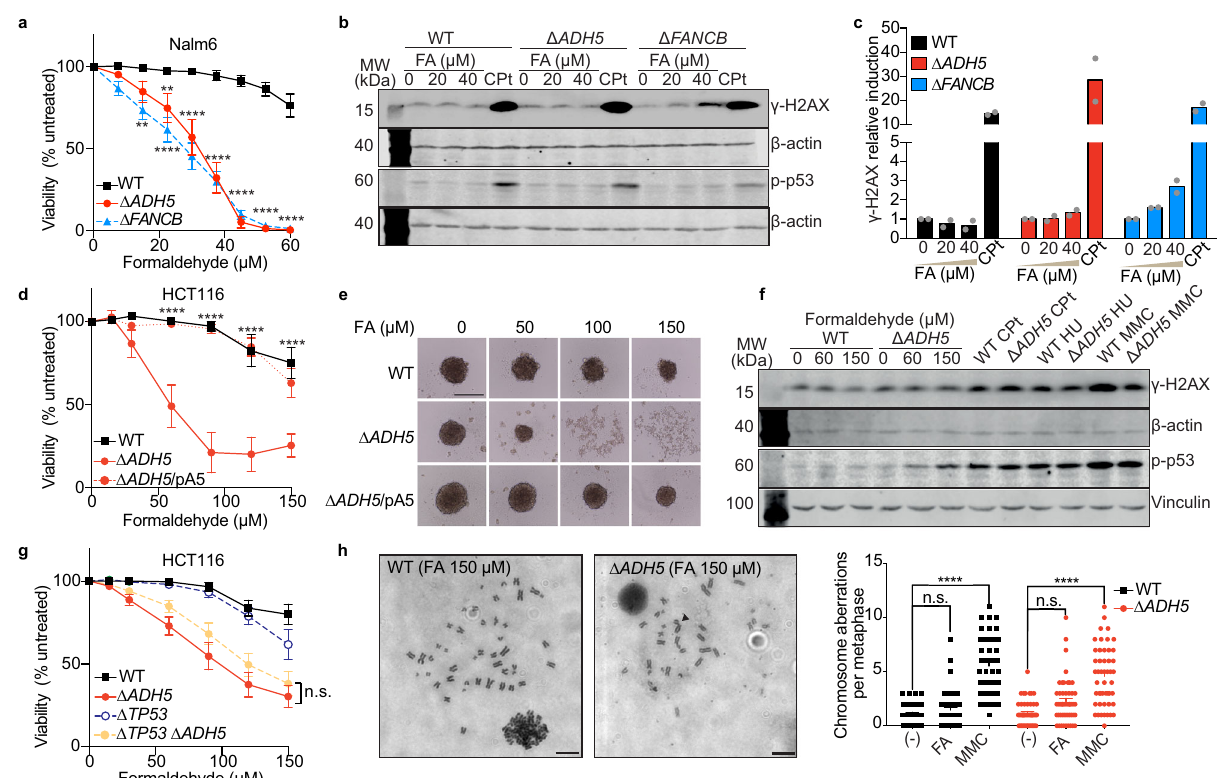
Fig. 1 ADH5 prevents formaldehyde toxicity in human cancer cells. a Viability assay for Nalm6 cells exposed to formaldehyde (FA) (mean ±SEM, n = 6, one-way ANOVA for multiple comparison using a Tukey-corrected test between Δ ADH5 or Δ FANCB and Wild type (WT) cell lines, ** P = 0.0011 (WT vs Δ FANCB 15 μ mol L − 1 FA), ** P = 0.004 (WT vs Δ ADH5 22.5 μ mol L − 1 FA), **** P < 0.0001). b Western blots depicting γ -H2AX and p-p53 signals after 48h of exposure to the indicated concentrations of FA, or after 24h to 8 μ mol L − 1 cisplatin (CPt) in Nalm6 cells. c Quanti fi cation of γ -H2AX western blots ( n = 2, mean relative to same cell line untreated). d Viability assay for HCT116 cells. Data are presented as mean (% of untreated) ± SEM, n = 6, two-way ANOVA for multiple comparison using a Tukey-corrected test between WT and Δ ADH5 HCT116 cells, **** P < 0.0001. e Representative images of 3D-sphere formation for WT, Δ ADH5 and Δ ADH5 / p ADH5 (pA5) HCT116 cells (scale bar 0.5mm). µ M refers to µ mol L − 1 and mM refers to mmol L − 1 . f Western blots showing the induction of p-p53 and γ -H2AX in HCT116 cell lines (48h for FA, 24h for Cpt (4 μ mol L − 1 ), hydroxyurea (HU, 1mmol L − 1 ) and mitomycin C (MMC, 1.5 μ mol L − 1 ). g Viability assay in the indicated HCT116 cell lines in the presence of FA (% of untreated, n = 8, mean ± SEM, n.s. not signi fi cant between Δ ADH5 and Δ TP53 Δ ADH5 , two-way ANOVA using a Tukey-corrected for multiple comparisons). h Representative images of metaphases obtained from WT and Δ ADH5 HCT116 cells exposed to 150 μ mol L − 1 FA (scale bar 1 µ m) and the quanti fi cation (MMC (1.5 μ mol L − 1 ) or FA (150 μ mol L − 1 ). Data are presented as mean ±SEM, n = 49, one-way ANOVA, Tukey´s multiple comparison test, **** P < 0.0001, n.s.: not signi fi